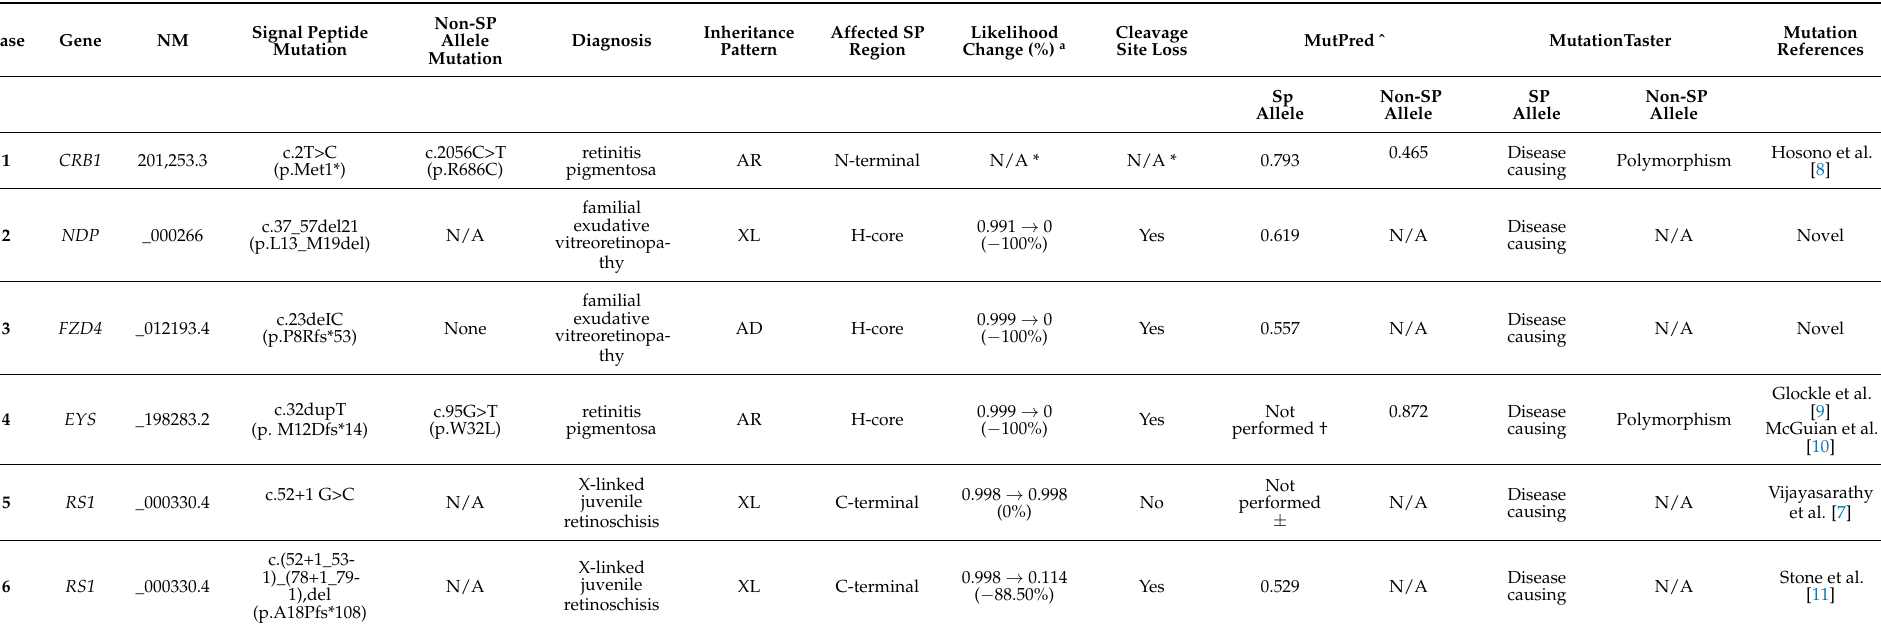
Table 1. Disease-causing SP Variants in Our Patient